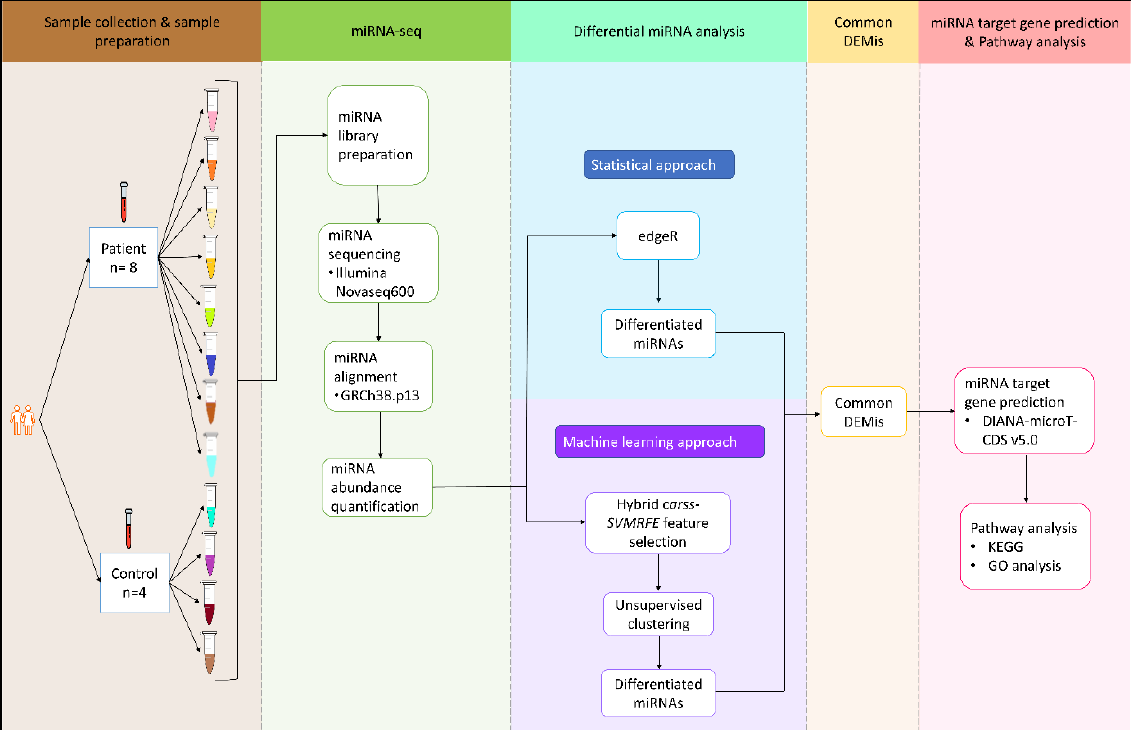
Figure 1. The framework for the differential expression analysis of miRNA in the blood of AD patients and that of normal controls. miRNA sequencing was conducted on the samples after appropriate preparation. The raw count data were analysed using bioinformatics. Differential miRNA expression analysis was carried out using two independent approaches, i.e., statistical and machine learning. Differentially expressed miRNAs (DEMis) were subjected to miRNA target gene prediction, followed by the evaluation of enriched pathways.